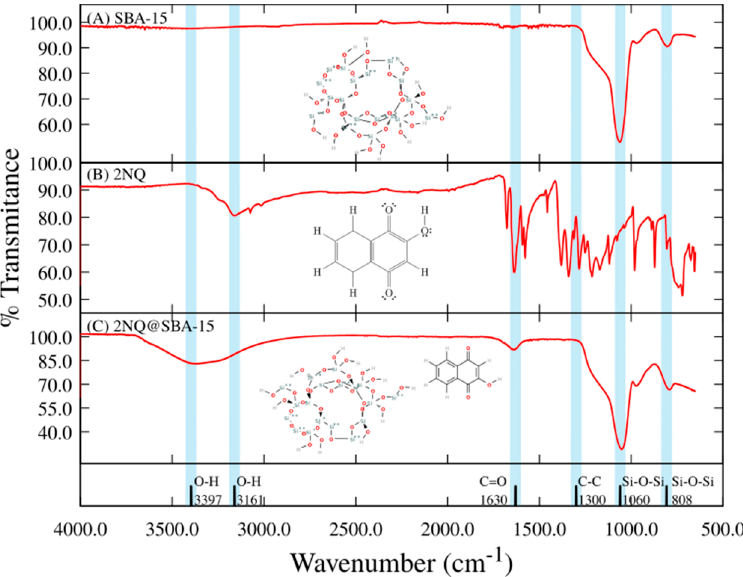
Figure 3. FTIR spectra from top to bottom: ( A ) SBA − 15, ( B ) 2NQ, and ( C ) 2NQ@SBA-15.